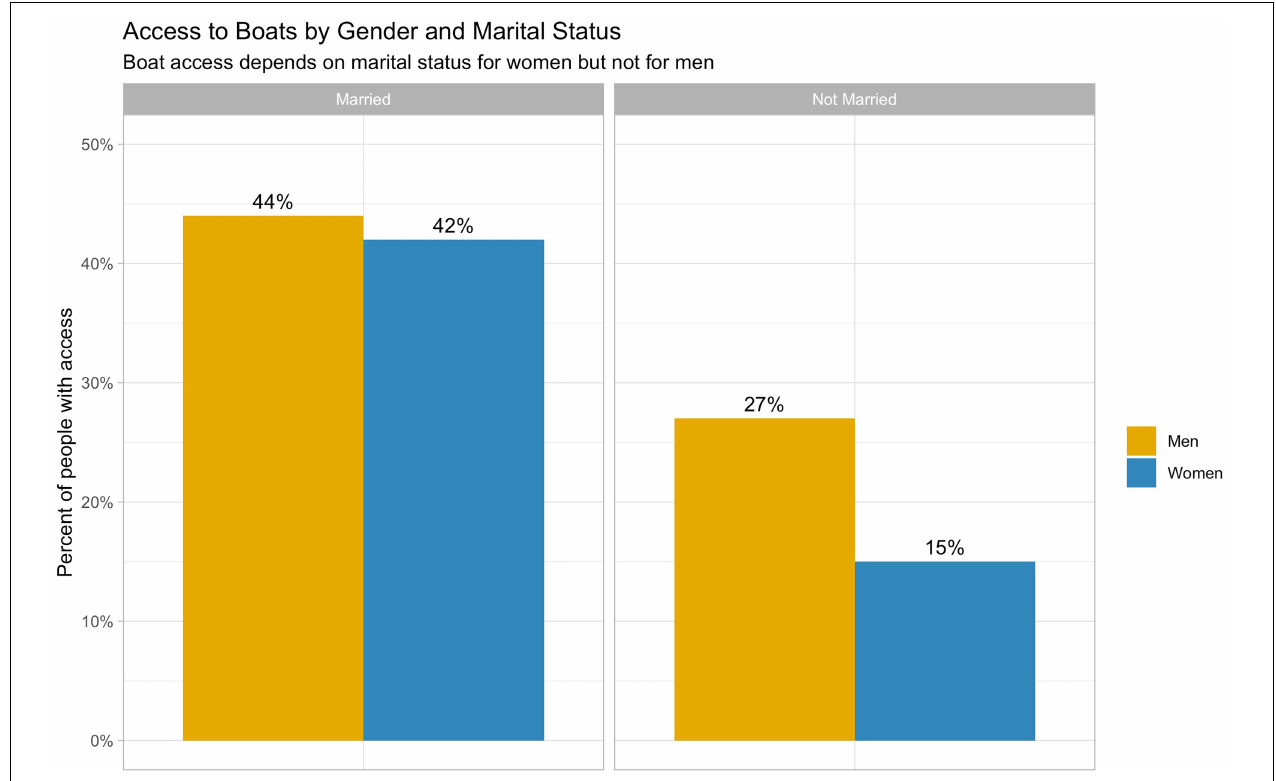
FIGURE 3 | Marital status determines access to boats for women but not for